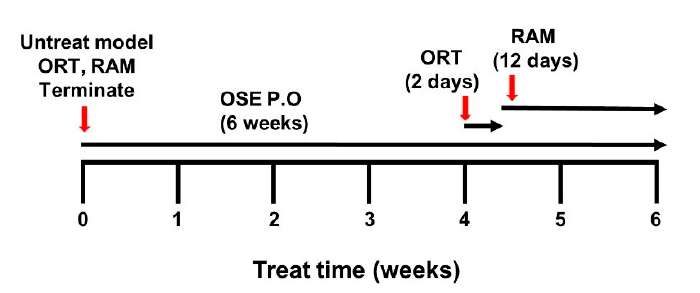
Figure 5. A schematic summary. A schematic summary of the experimental procedure. Total distance covered, as well as the time taken by mice, are in the center zone.